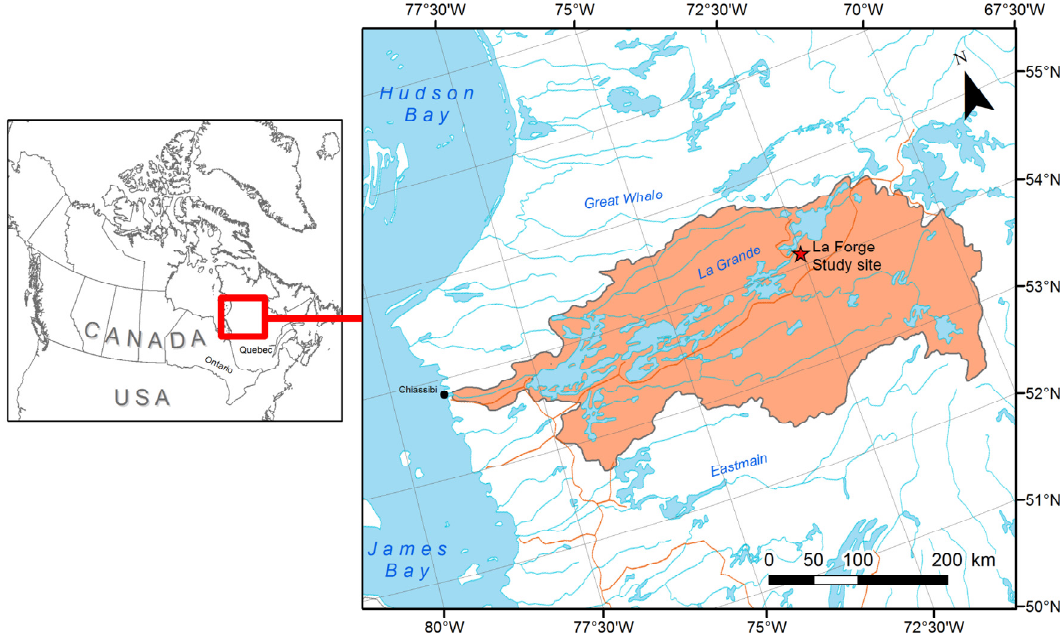
Figure 1. Location of the “La Grande” basin in the north-central part of the Province of Quebec